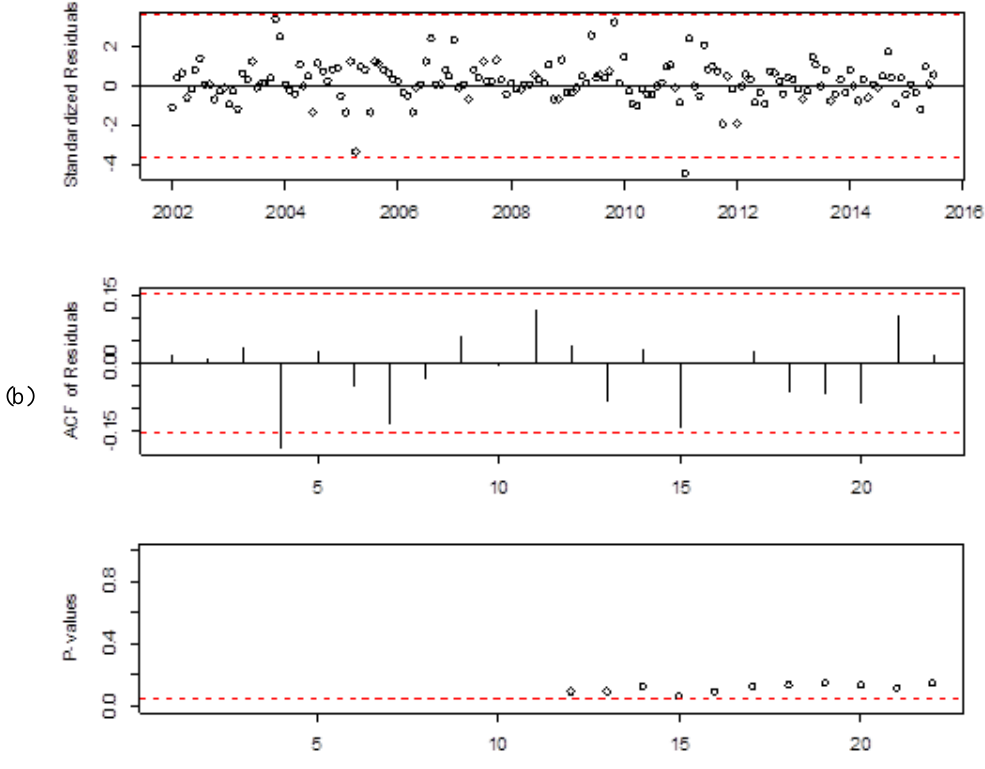
Figure 5. The (i) ACF and PACF plot for the residuals of the model ARIMA (2, 1, 2) of LogMCAP, (ii) Diagnostic Display of the model ARIMA (2, 1, 2) of LogMCAP